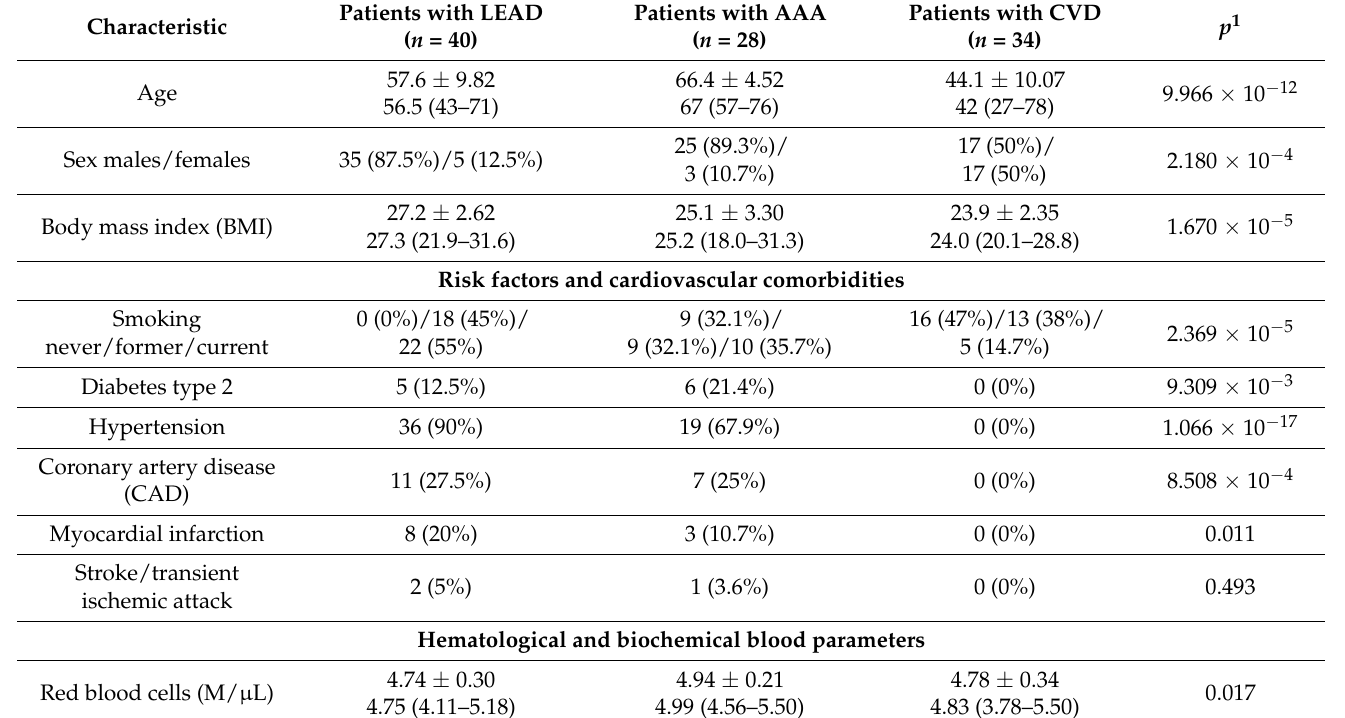
Table 1. Demographical and clinical information regarding the study subjects. The table presents extended data gathered from our previous studies